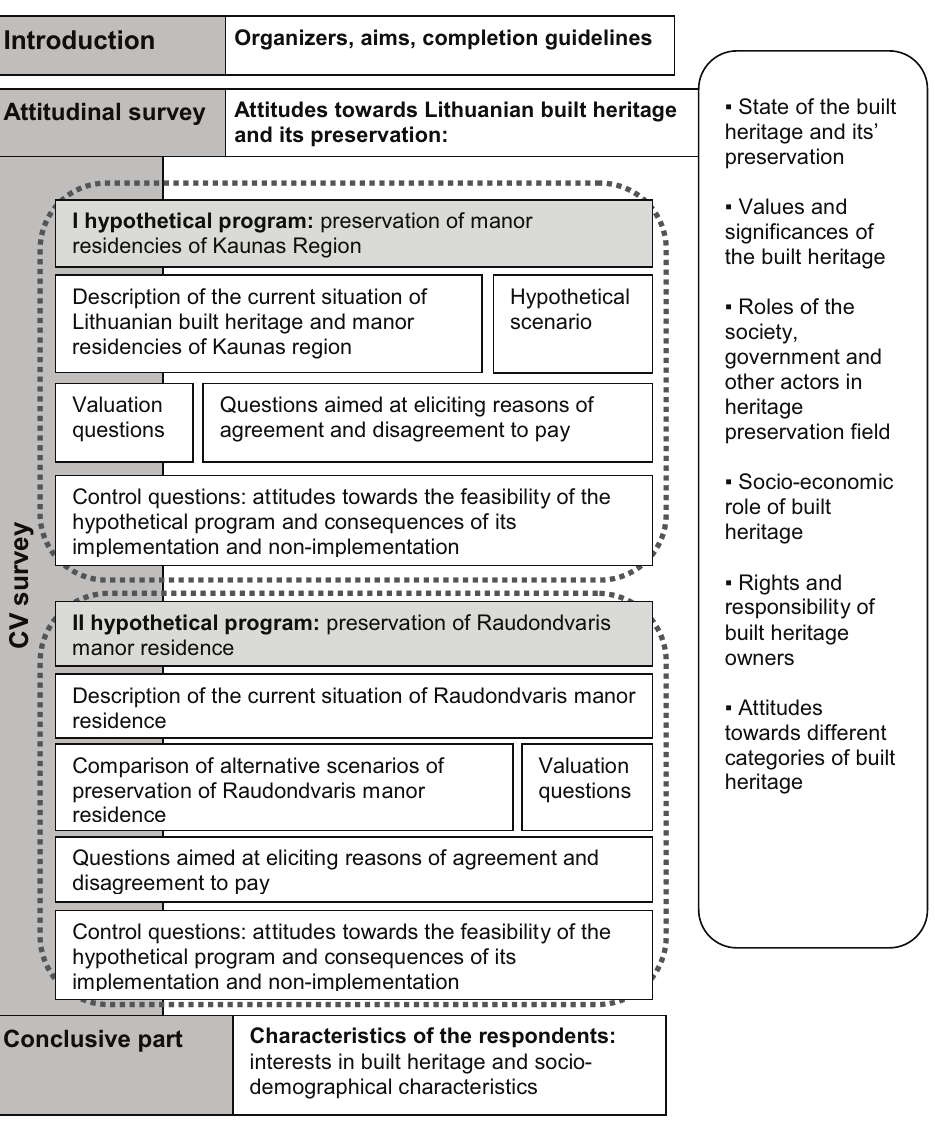
mental built heritage survey is one of the first in the region and can provide significant data for the future researches. Consequently, the combination of the dichotomous choice